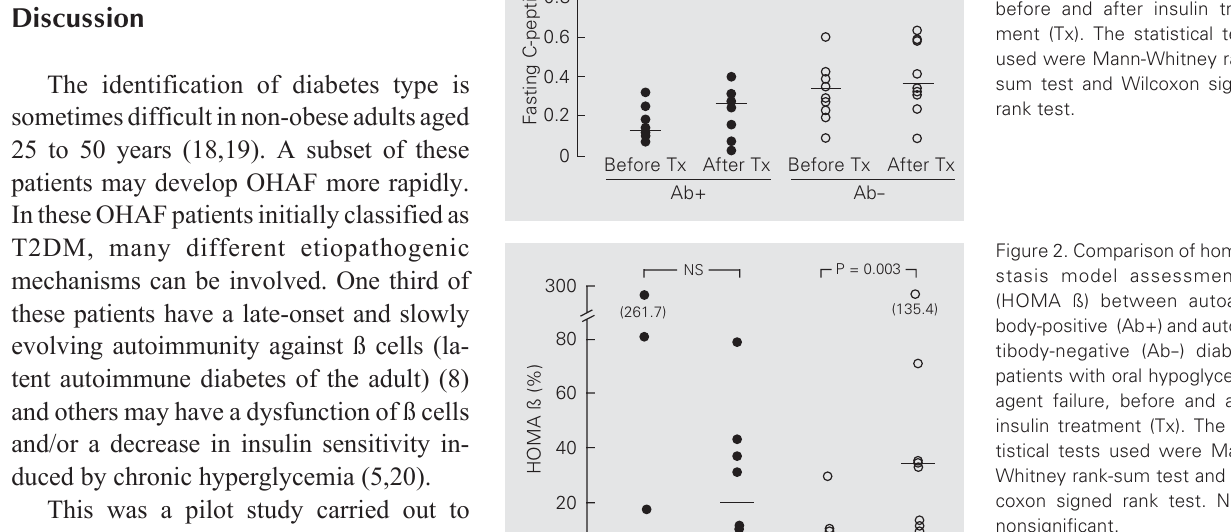
Figure 1. Comparison of fasting C-peptide (nmol/l) levels be- tween autoantibody-positive (Ab+) and autoantibody-nega- tive (Ab-) diabetic patients with oral hypoglycemic agent failure before and after insulin treat- ment (Tx). The statistical tests used were Mann-Whitney rank- sum test and Wilcoxon signed rank